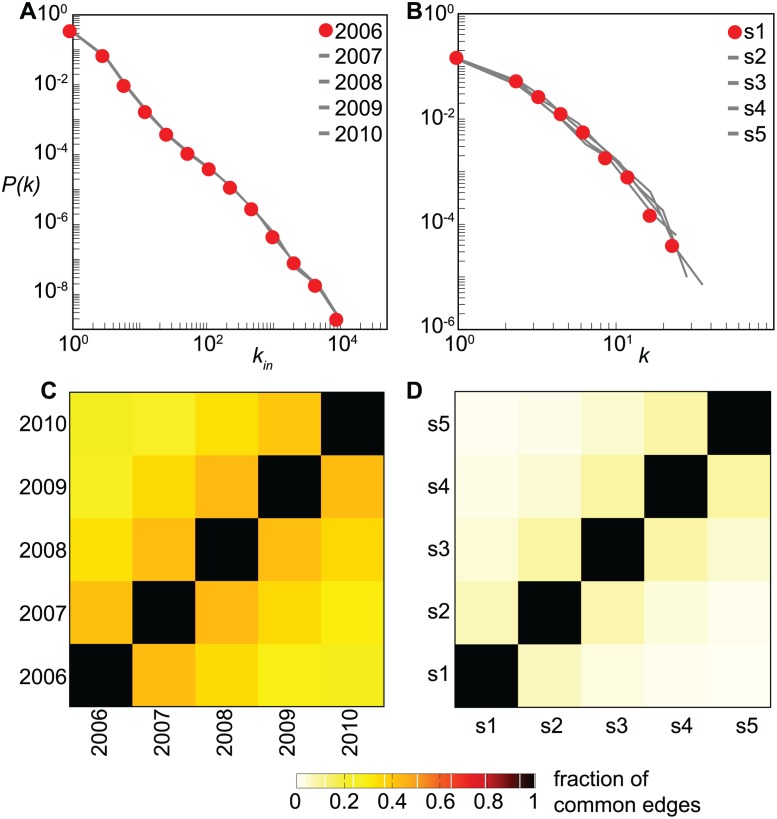
Structural and temporal properties of the cattle trade network and of the sexual contact network.(A), (B): premises in-degree distributions in the cattle trade network and sex customers degree distribution in the sexual contact network, respectively. Distributions for different configurations of the networks are superimposed in both cases. (C), (D): fraction of common edges contained in two configurations of the network, for the cattle trade network and the sexual contact network, respectively. In (B), (D) s stands for semester, the aggregation interval of each configuration.